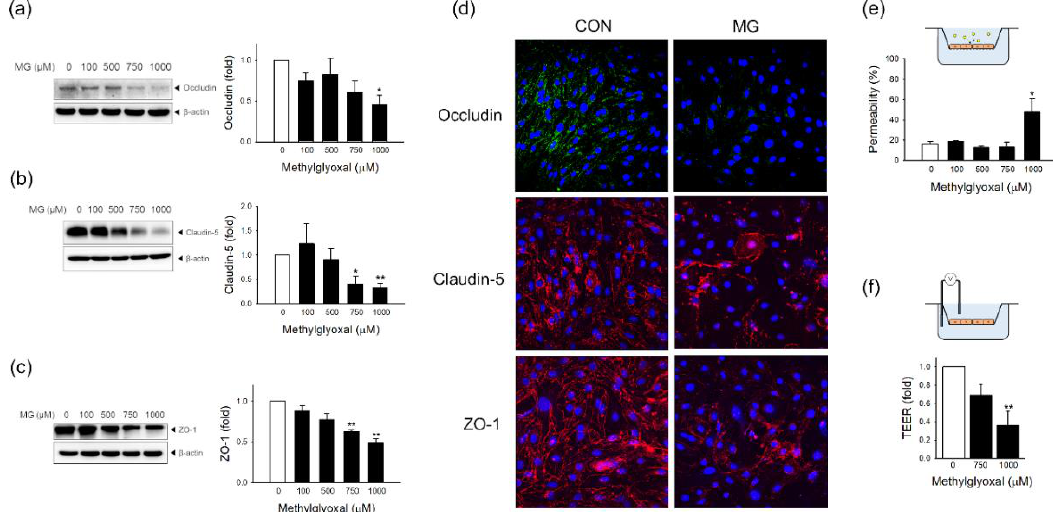
Figure 6. MG induces endothelial dysfunction through tight junction degradation and permeability destruction in bEND.3 cells. The protein expression levels of ( a ) occludin ( n = 5), ( b ) claudin-5 ( n = 4), and ( c ) ZO-1 ( n = 3) were determined 24 h after treatment with 100 –1000 μM MG by western blotting. ( d ) MG-exposed bEnd.3 cells were stained with an antibody against occludin, claudin-5, or ZO-1 and visualized by confocal microscopy. Scale bar: 50 μm. ( e , f ) Functional changes in endothelial permeability were measured by ( e ) an in vitro FITC-dextran permeability assay ( n = 3 – 7) and ( f ) TEER measurements ( n = 4) after MG treatment. Representative images are shown. Data are presented as mean ± SEM. * p < 0.05, ** p < 0.01 vs. control (CON).